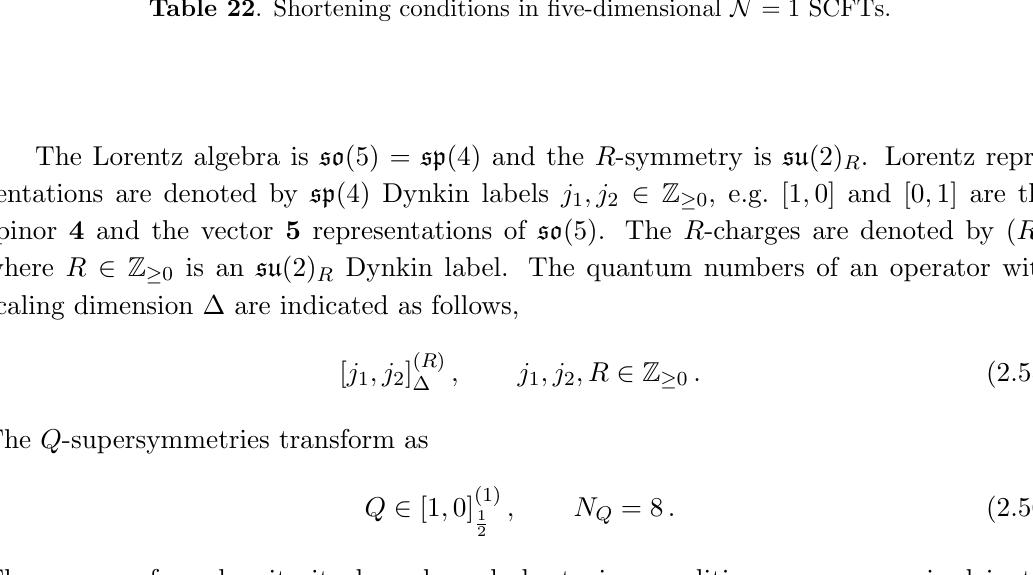
Table 22 . Shortening conditions in (cid:12)ve-dimensional N = 1